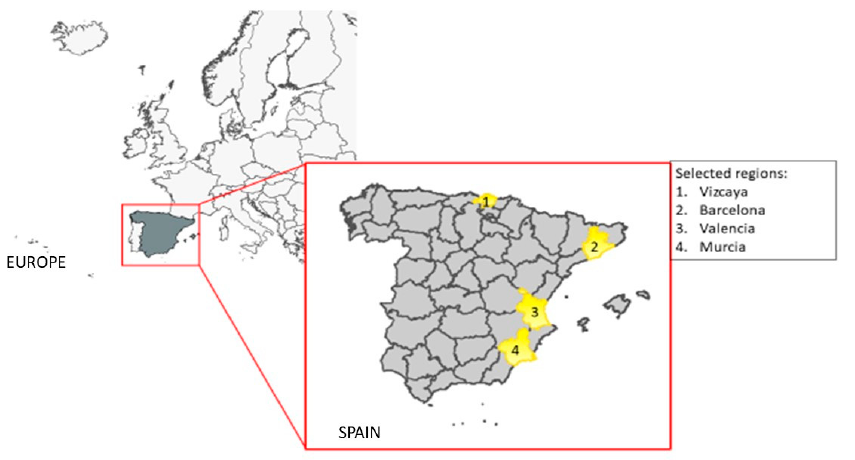
Figure 1. Spanish regions selected for the study.